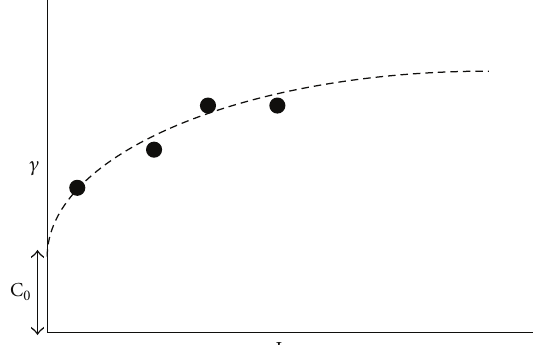
Figure 15: Comparison between “GeoEAS” and “comma separated values” formatted datafiles.